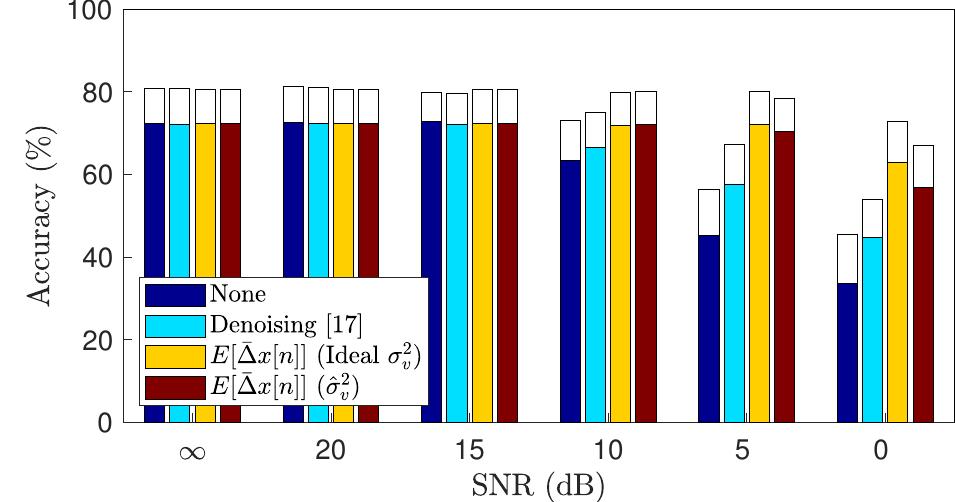
Figure 8. Subject-averaged accuracy comparison. Colored bar represents average accuracy using each method explained in legend; white bar above colored bar represents corresponding standard